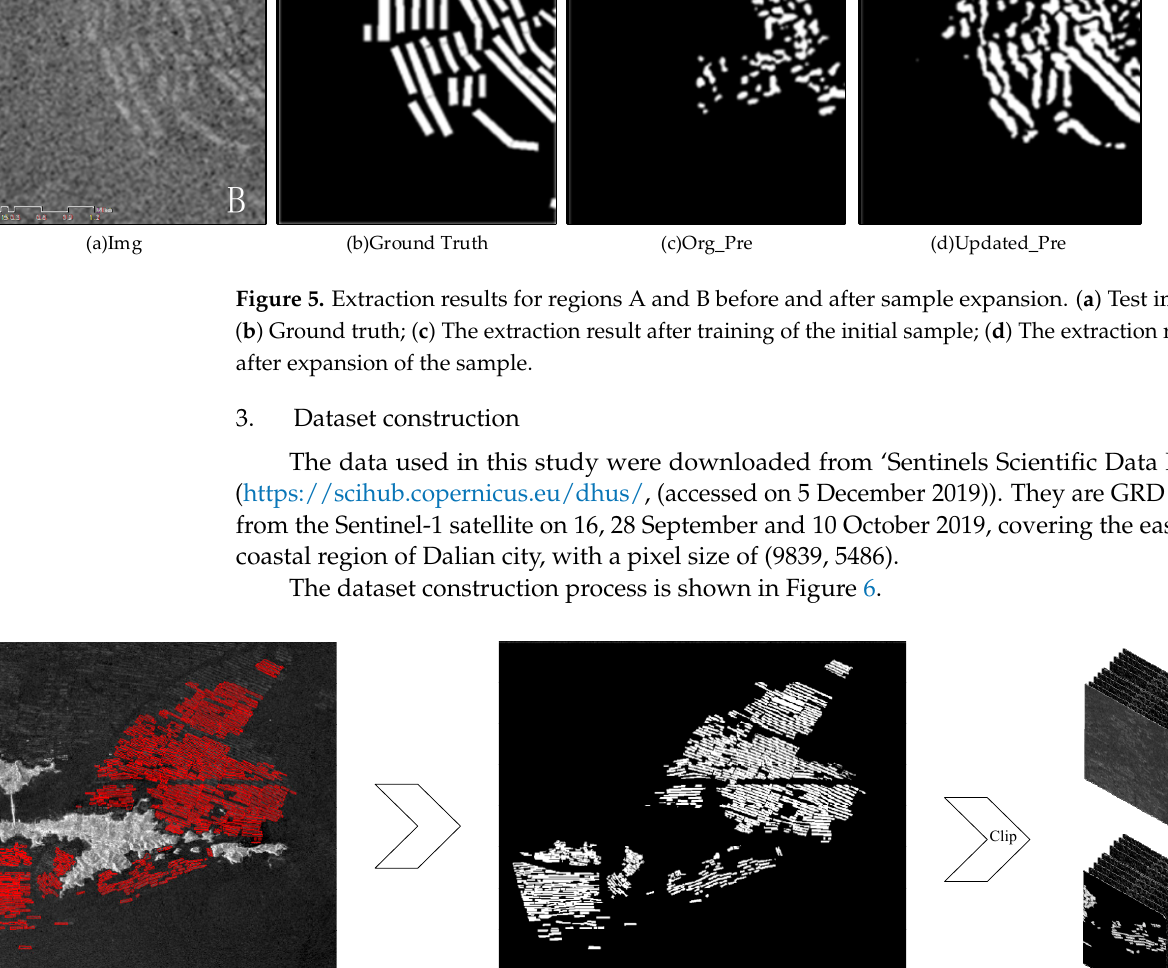
on result after expansion of the sample Figure 6. Overview of the dataset construction process. Figure 6. Overview of the dataset construction